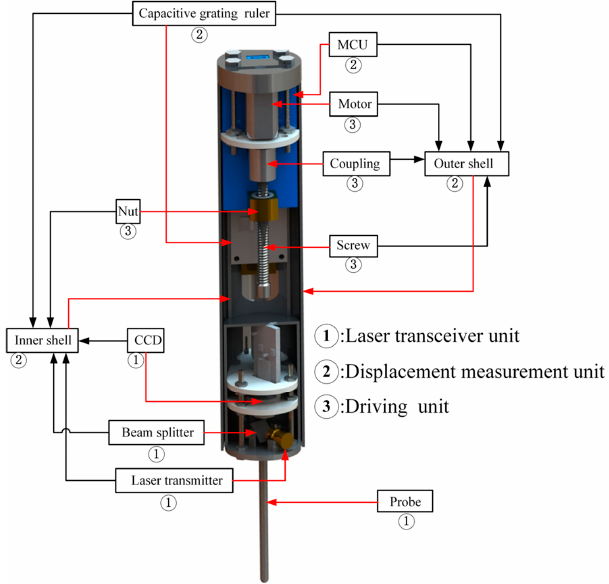
Figure 4. Internal structure of the measuring device; MCU: microcontroller unit.